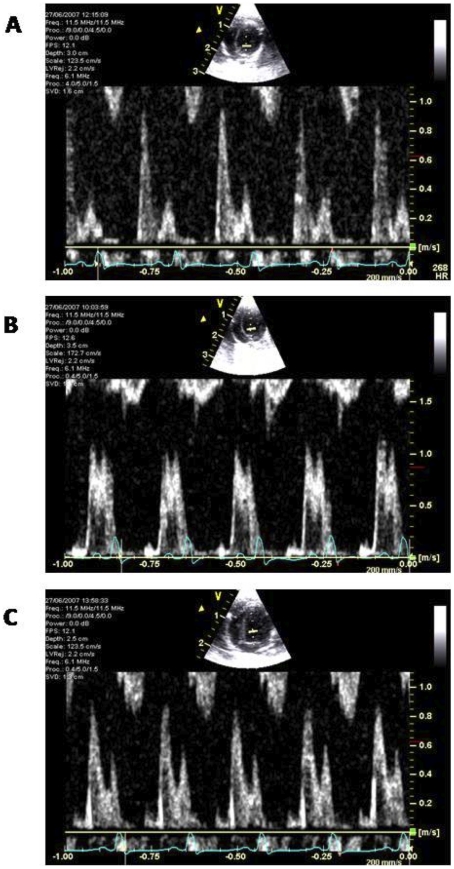
Representative apical view pulsed wave Doppler studies.In control rats (A) “normal” left ventricular (LV) filling pattern were observed, whereas diabetic rats (B) had reduced LV function. These changes were distinguished by delayed ventricular relaxation, characterized by reduction in the E wave and an increase in the late atrial A wave and prolongation of the deceleration time. Treatment with DiOHF showed improvement in LV function of diabetic rats (C).